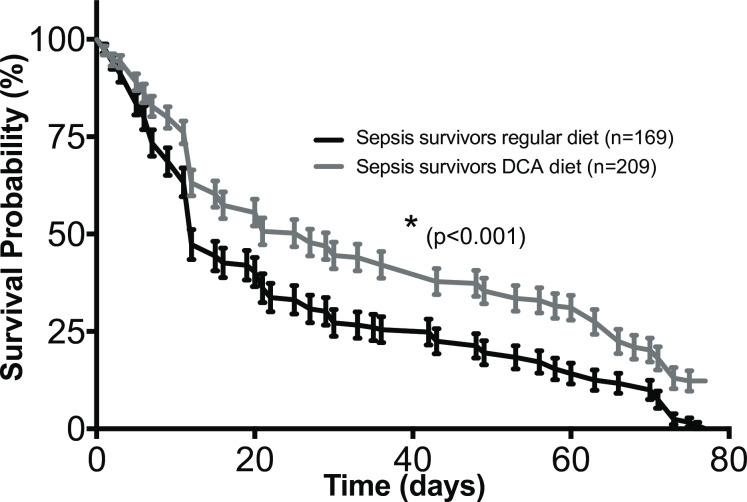
Drosophila lifespan after surviving sepsis is prolonged after a 1-week exposure to DCA.The flies were divided into 3 experimental groups: unmanipulated, sham, and sepsis survivors. To study the impact of DCA in diet, each experimental group was further divided into 2 groups depending on DCA treatment [DCA (-) and DCA (+)]. Survival of Drosophila melanogaster after septic injury with Staphylococcus aureus was assessed after the initial 4–6 hours to exclude trauma-associated mortality. All flies received oral linezolid (0.5 mg/mL) for 18 h. Lifespan analysis was performed using the Kaplan-Meyer survival analysis. In the DCA (+) groups, flies were fed DCA (0.5 mg/mL) only for 1 week following sepsis and then switched back to regular diet. The DCA (+) sepsis survivors had improved lifespan compared to flies that were fed regular diet (*p < 0.001).